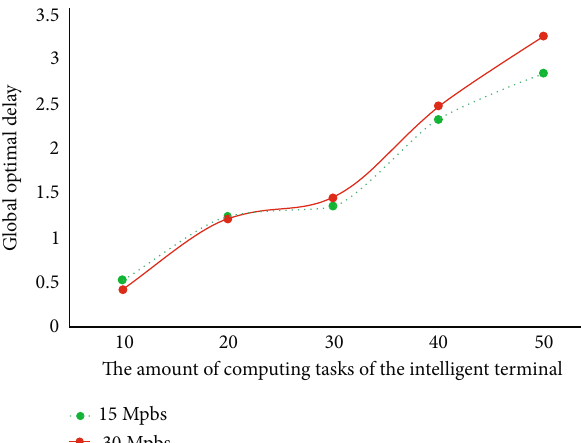
Figure 3: Ratio of global optimal delay.